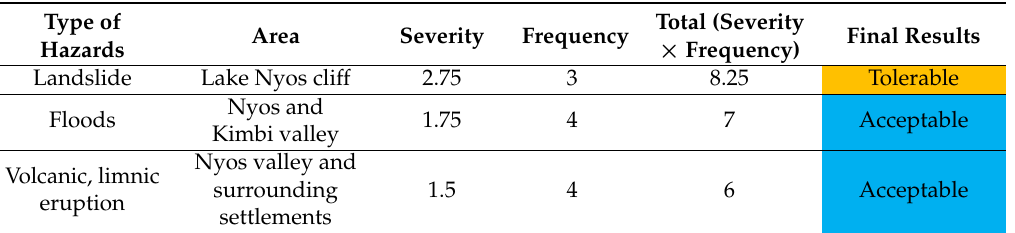
Table 10. Vulnerability index of the main hazards occurring at the lake Nyos after degassing and jet grouting